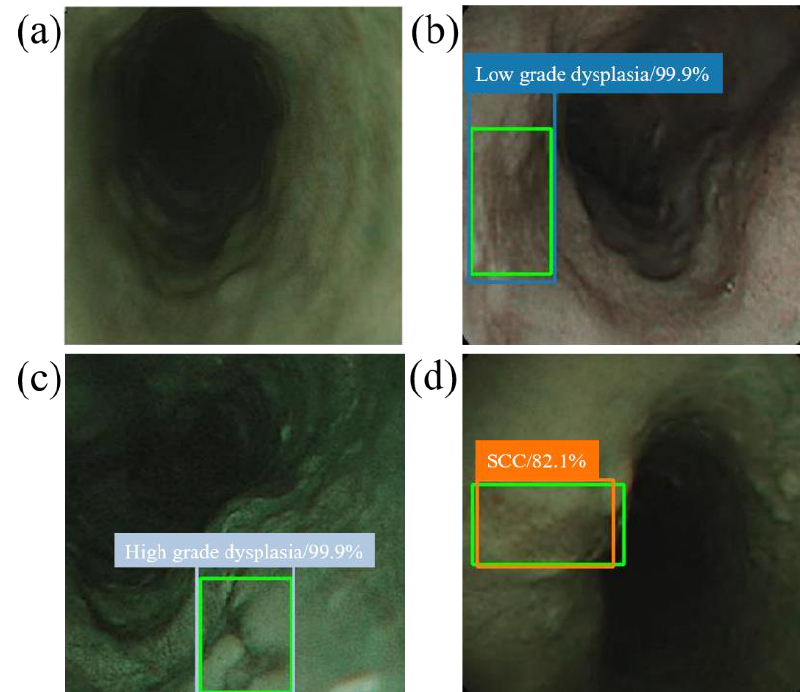
Figure 5. SSD diagnostic result of NBI esophageal neoplasm image. All green boxes in the figure are ground truth. The numbers in the label indicate the probability of being judged as the number of esophageal cancer stages in the box. ( a ) Image of a normal esophagus. No frame is displayed under the SSD diagnosis. Thus, the SSD diagnosis was normal esophagus. ( b ) Esophageal endoscopy image with a low-grade dysplastic area. Under SSD diagnosis, a blue border box is displayed around the lesion area, and the lesion area is therefore determined to be low-grade dysplasia. ( c ) Esophageal endoscopic image with an area of high-grade dysplasia. Under SSD diagnosis, a gray border box is displayed around the lesion area, and the lesion area is therefore determined to be high-grade dysplasia. ( d ) Esophageal endoscopic image with an esophageal cancer area. Under SSD diagnosis, an orange bounding box surrounds the lesion area and determines that the lesion area is